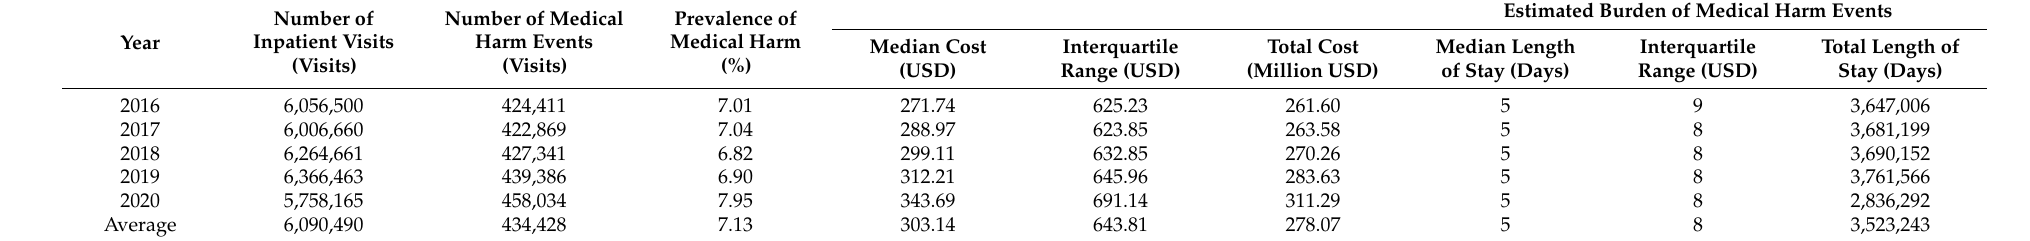
Table 1. Number of Thai inpatient medical harm events between 2016 and 2020.